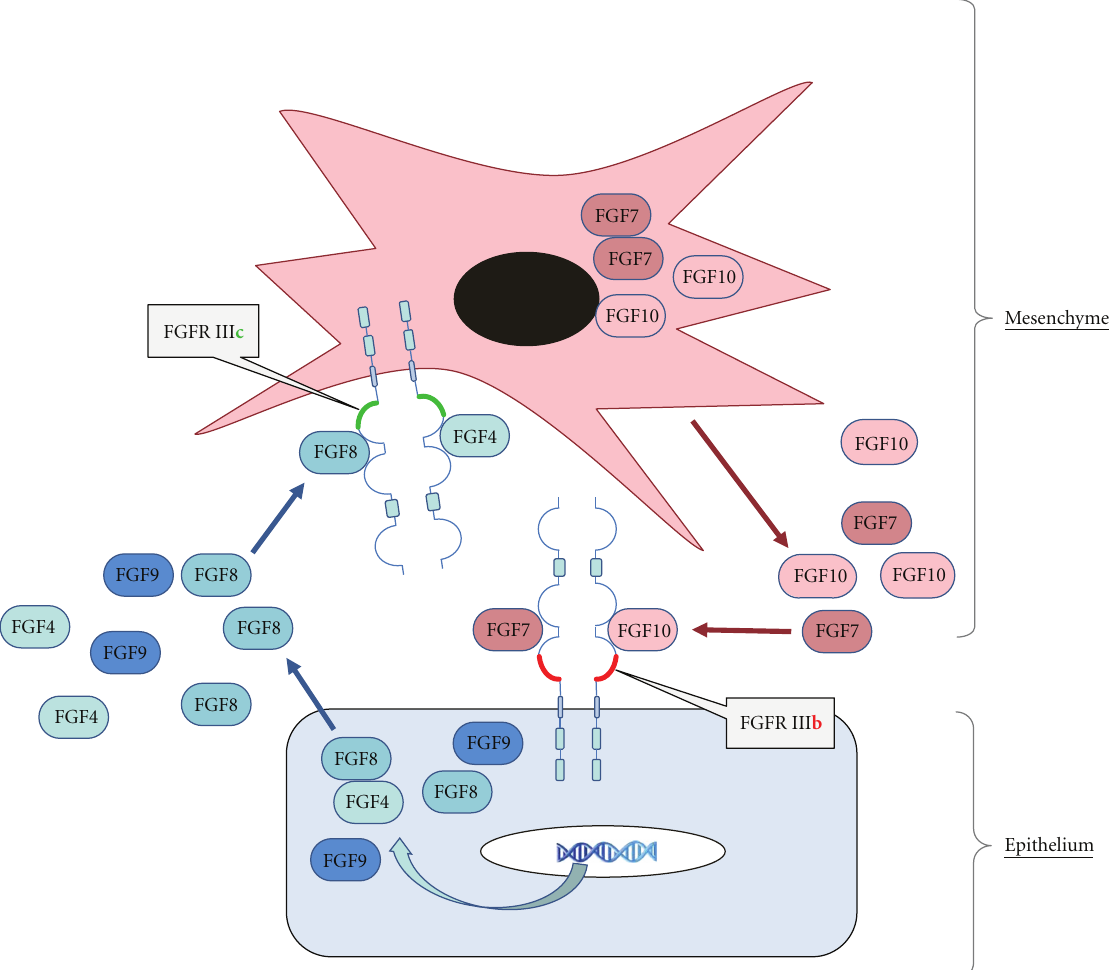
Figure 2: Tissue interactions mediated by IIIb/IIIc splice variants. Expression of FGFR2 variants is strictly tissue specific with the IIIb form found in the epithelium and the IIIc form in the mesenchyme. Together with expression of splice form-specific ligands in the respective complementary tissue, the splice variants mediate tissue interaction during embryonic development as well as in tissue maintenance and repair. The example FGFR2 with the IIIb-specific ligands FGF7 and 10 and the IIIc-specific ligands FGF4, 8 and 9, is involved in mouse limb development as well as in wound healing and reepithelialization in the skin